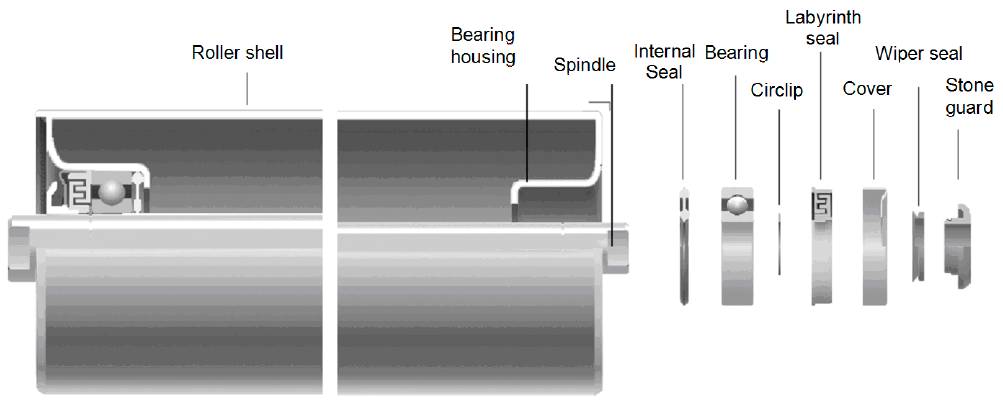
Figure 2. Typical roller assembly.